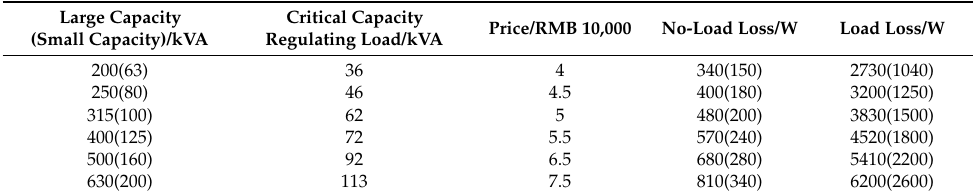
Table 2. Parameters for on-load capacity regulating distribution transformers.